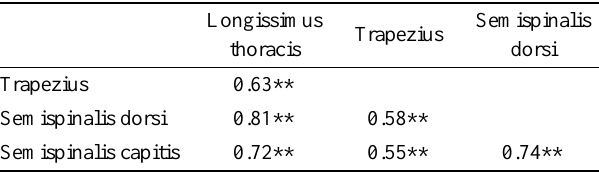
Table 2. Simple correlation coefficients of beef muscle area between longissimus thoracis, trapezius, semispinalis dorsi and semispinalis capitis muscles by image